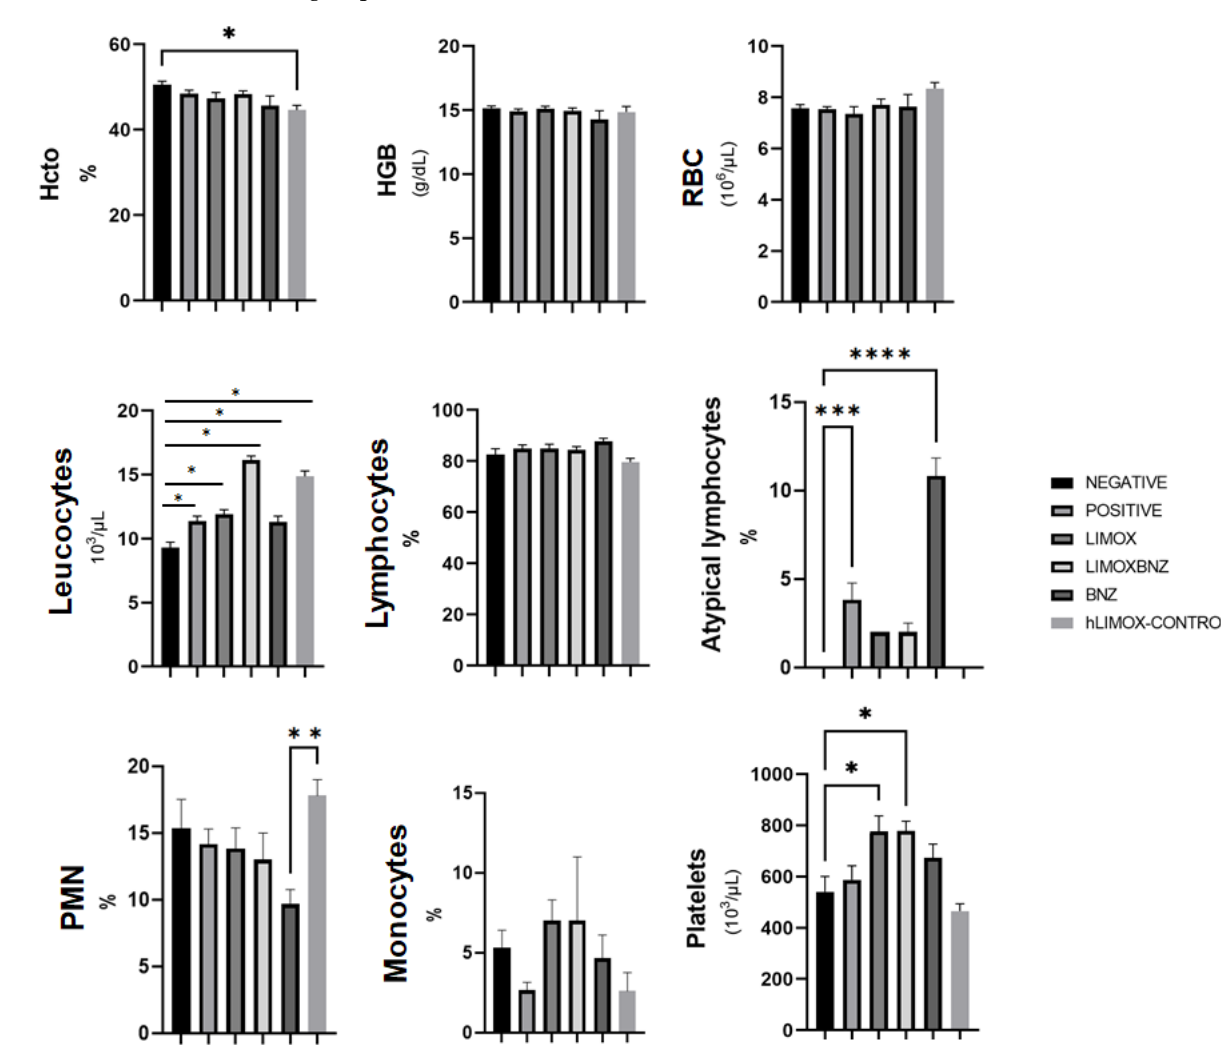
Figure 6. Hematological findings in Wistar rats infected with Trypanosoma cruzi . Hcto: Hematocrit; HGB: Hemoglobin; Negative: untreated, uninfected animals; hLIMOX-Control: not infected animals, treated with higher doses of an essential oil fraction of Lippia alba carvone chemotype enriched in limonene (170 mg/kg/day) and with added caryophyllene oxide (Sigma-Aldrich) (70 mg/kg/day); Positive: untreated, infected animals; LIMOX: infected animals treated with an essential oil fraction of Lippia alba carvone chemotype (enriched in limonene) (68.9 mg/kg/day) with added caryophyllene oxide (Sigma-Aldrich) (70 mg/kg/day); LIMOXBNZ: infected animals treated with LIMOX plus benznidazole (7.9 mg/kg/day); BNZ: infected animals treated with benznidazole (100 mg/kg/day). * p < 0.05 compared to the negative control group; ** p < 0.05 compared to the BNZ group; *** p < 0.005 compared to the negative control group **** p < 0.0001 compared to the negative control group. Data are representative of six independent experiments and values are expressed in mean ± SEM.